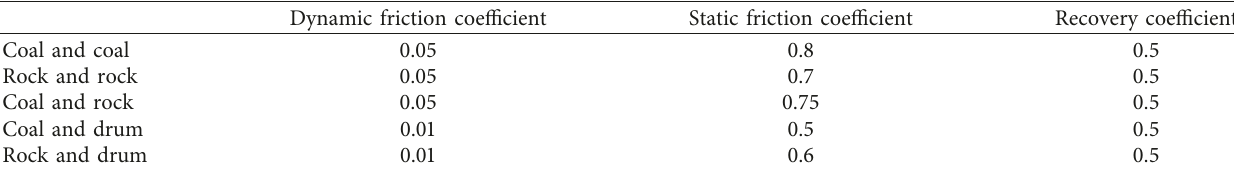
Table 1: Particle parameters of coal rock.